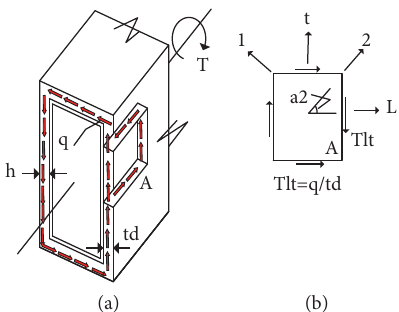
Figure 1: Reinforced concrete section subjected to torsion: (a) shear flow of the cross-section and (b) in-plane stress state of element